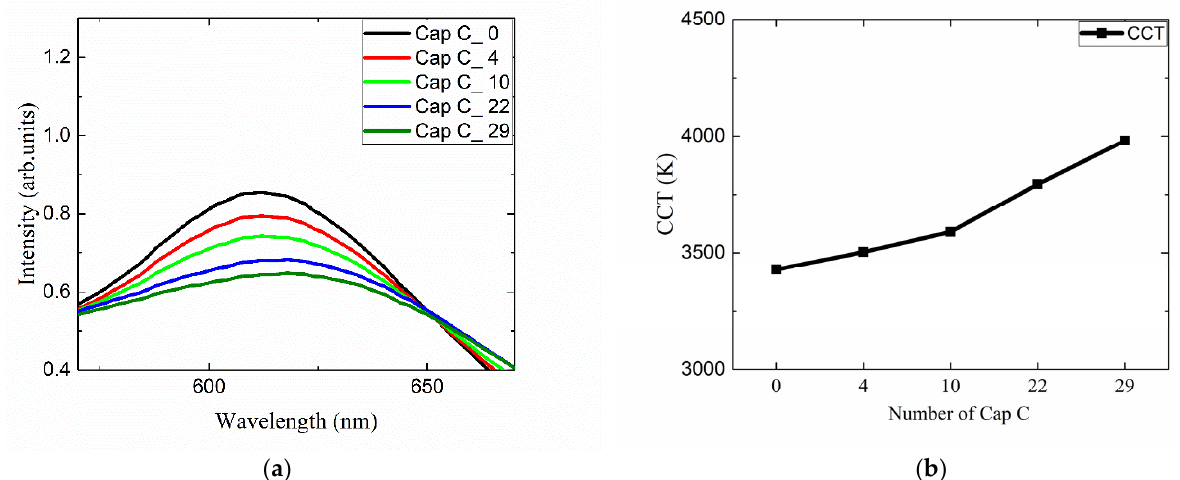
Figure 11. The dependence of ( a ) the emitting spectrum in the red region and ( b ) the CCT on the number of replaced caps.